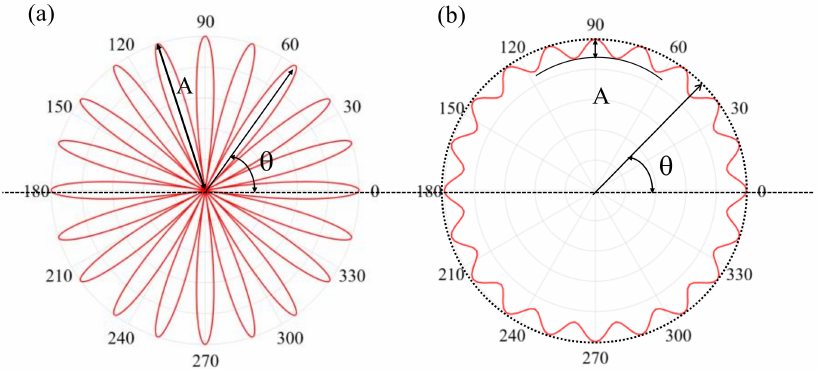
Figure 4. Design of 20-order wheel polygon: ( a ) 20-leaf rose line and ( b ) 20-order wheel polygon.